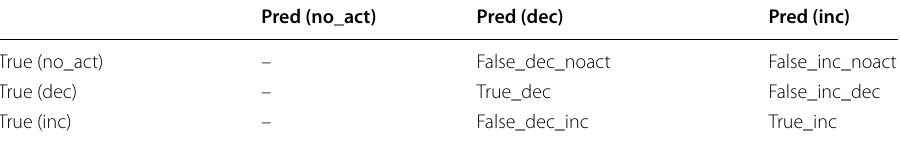
Table 2 Sample table for profit_accuracy